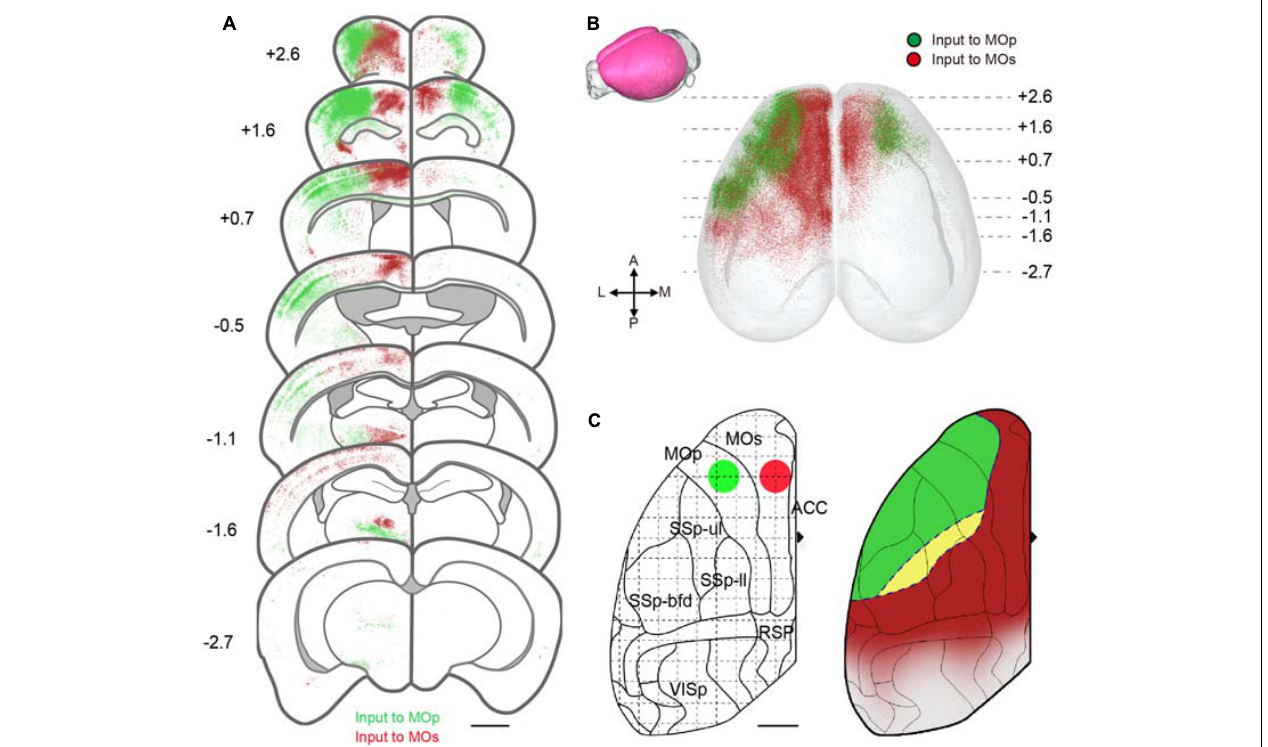
FIGURE 5 | Region-specific cortical projection to MOp and MOs. (A) Coronal sections show inputs to the motor cortex from different cortical regions. The green signals indicate the neurons projecting to the Mop, while the red signals indicate the neurons projecting to the MOs. Scale bar = 1 mm. (B) Three-dimensional reconstruction of cortical areas. A dot denotes one neuron projecting to the MOp (green) or MOs (red). (C) Schematic diagram for input areas projecting to subregions of the MC. The green and red circles represent injection site positions. Green areas indicate regions mainly projecting to the Mop, while red areas indicate regions mainly projecting to the MOs; yellow areas indicate regions projecting to both the MOp and MOs. Scale bar = 1